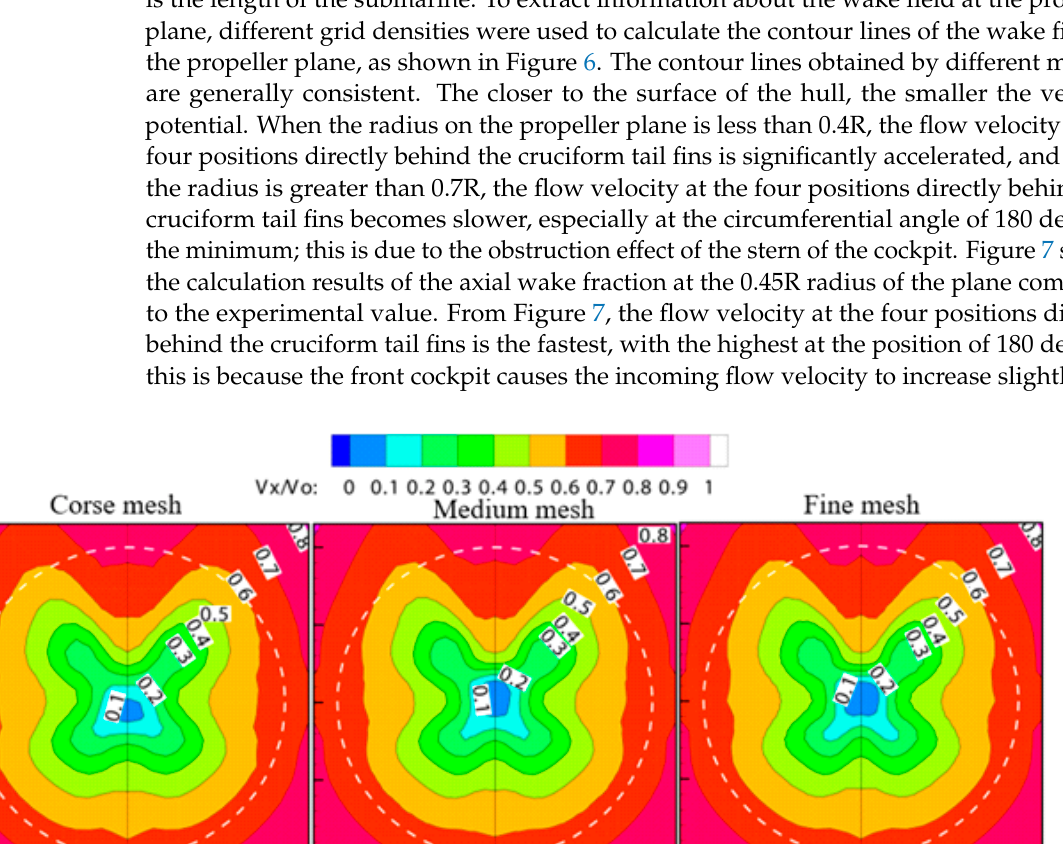
Figure 7. Axial wake friction at the propeller plane. 4. Results Analysis and Discussion 4.1. Distribution of Velocity Figure 8 shows contour plots for the axial velocity on the propeller plane for di ff erent designs, with the white do tt ed line representing the propeller radius. It can be seen that the axial velocity distribution on the outer radius is similar for all designs, with the wing mainly a ff ecting the velocity distribution at the inner radius, particularly at the 180-degree position. Comparing the original design to the improved design, it can be seen that, in the original design, velocity contours less than 0.5 show a clear contraction at the rear of the wing, mainly caused by the horseshoe vortex released from the wing. However, the con- traction at the rear of the wing is signi fi cantly reduced in the improved design. Figure 9, through the Q criterion, shows the vortex distribution around the submarine for both de- signs. It can be seen that, with the wing improvement, the horseshoe vortex above the propeller plane is signi fi cantly reduced, and the horseshoe vortex on the bo tt om side of the propeller plane disappears, showing a clear vortex suppression e ff ect of the wing.